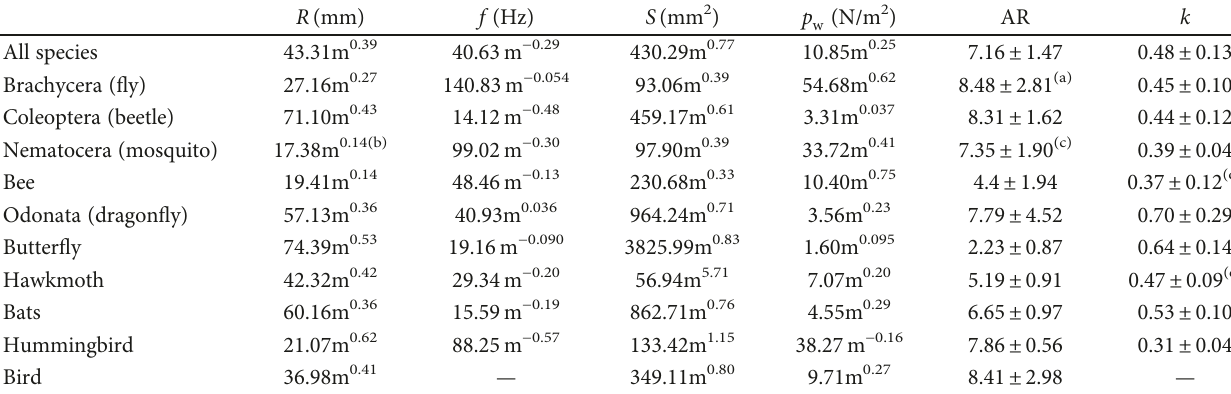
Table 3: Power functions of wing dimensions and fl ight parameters vs. body mass.